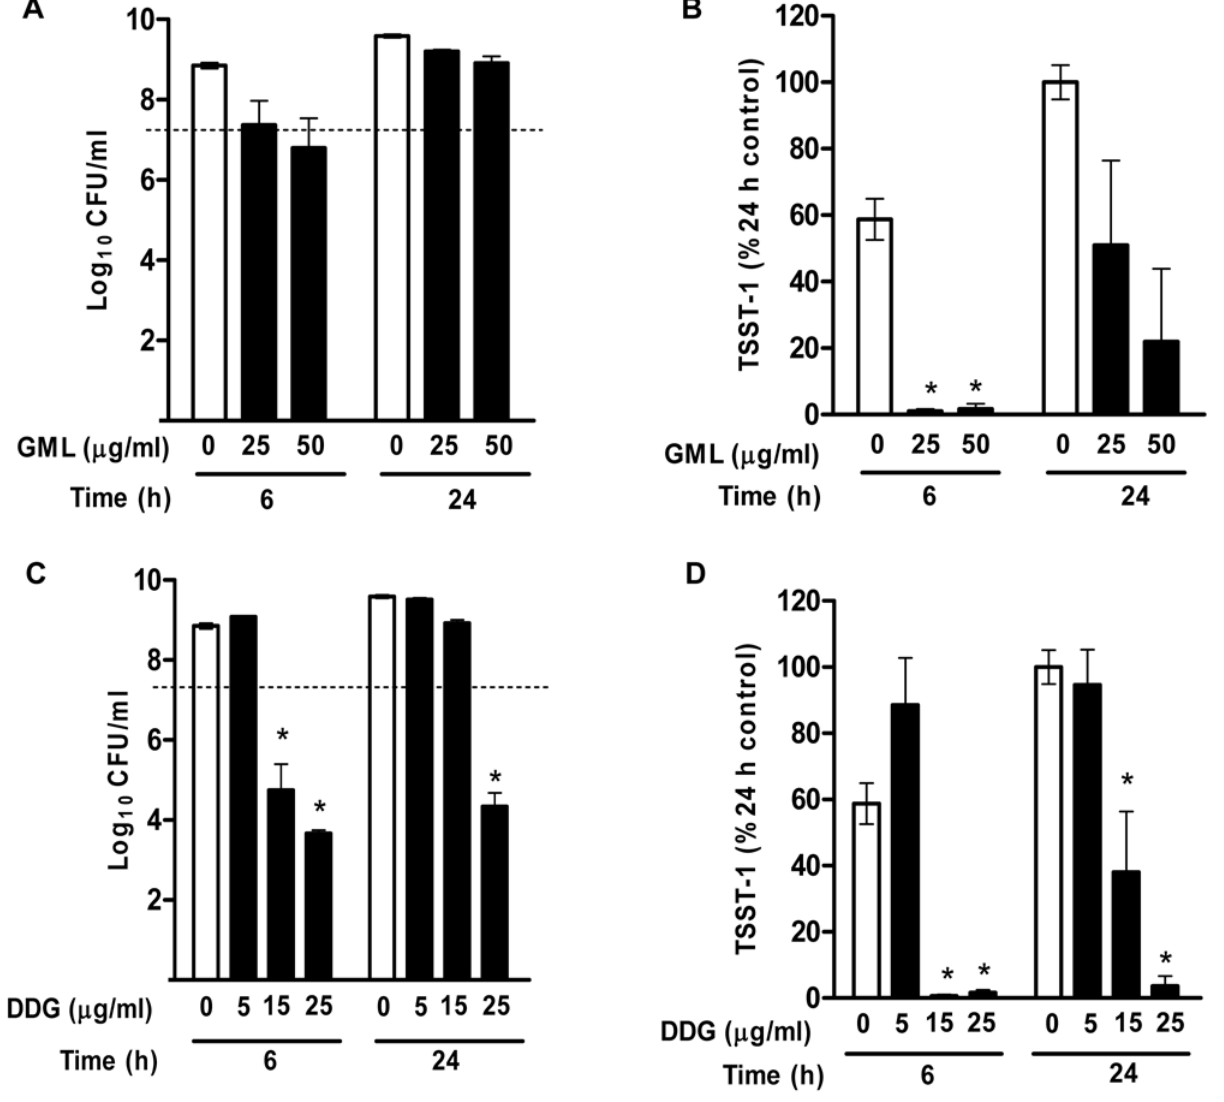
Figure 4. Effects of GML and DDG on Staphylococcusaureus Toxic Shock Syndrome Toxin-1 (TSST-1) production. (A) S. aureus MN8 was exposed to GML 0, 25 and 50 m g/ml for 6 and 24 h, and bacterial densities at 6 and 24 h were determined by plate counts. (B) The corresponding concentrations of TSST-1 of the above GML experiment. (C) S. aureus MN8 was exposed to DDG 0, 5, 15, and 25 m g/ml for 6 and 24 h. (D) The corresponding concentrations of TSST-1 from above DDG experiments. TSST-1 concentrations are presented as percent of the TSST-1 concentrations in 24 h control samples. Results are mean 6 SEM. The dashed line indicates the starting inocula. *, p , 0.05.